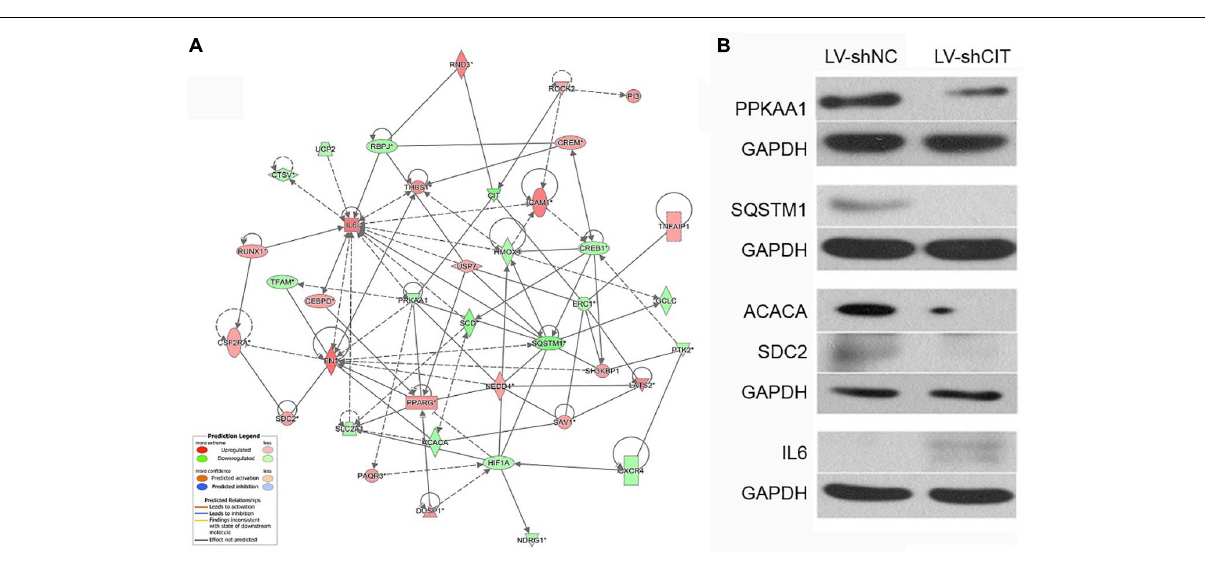
FIGURE 5 | CIT-related genetic network and downstream gene verification. (A) Gene interaction network showing the interaction network between molecules related to cell proliferation and apoptosis. (B) Expression of several downstream key genes (PRKAA1, SQSTM1, ACACA, SDC6, and IL6) was verified with western blot